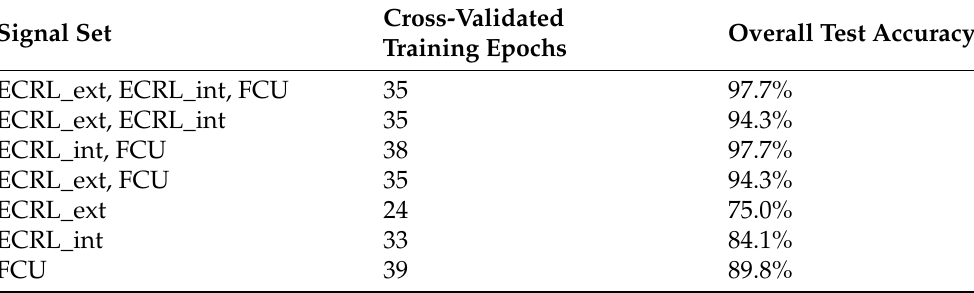
Figure 12. The Pearson’s correlations between the signals, grouped by the type of executed motion (see Table 1 for the motion labels description and Figure 11 for signal sites abbreviations). The corre- lations are given for raw and digitally high-pass filtered signals with a 5 Hz cut-off frequency. Table 2. Classification task results—test accuracies (see Figure 11 for the description of the signal